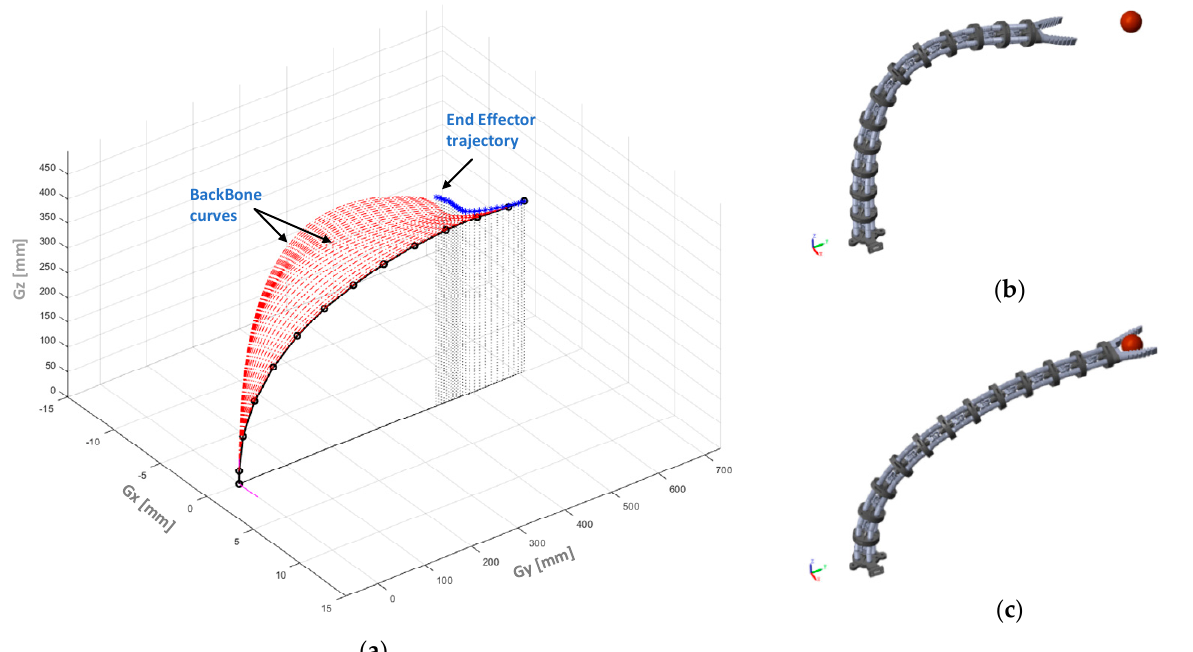
Figure 9. Python virtual model in Simscape ( a ) backbone curve for the imposed trajectory ( b ) initial position ( c ) final position.